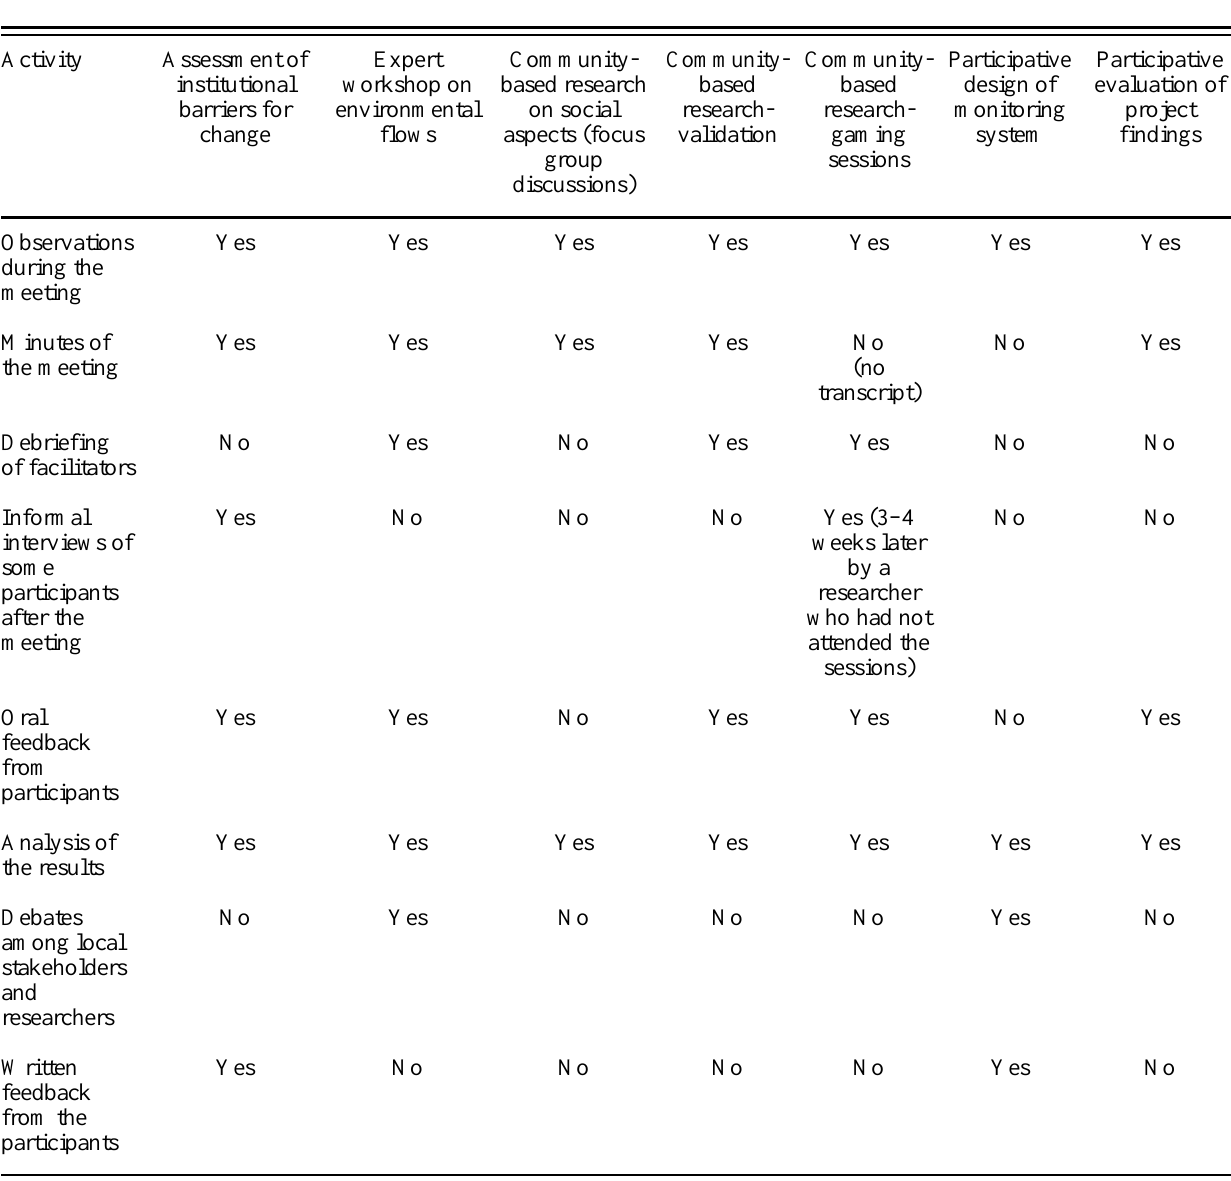
Table 3 . Data used for evaluation of participative activity.